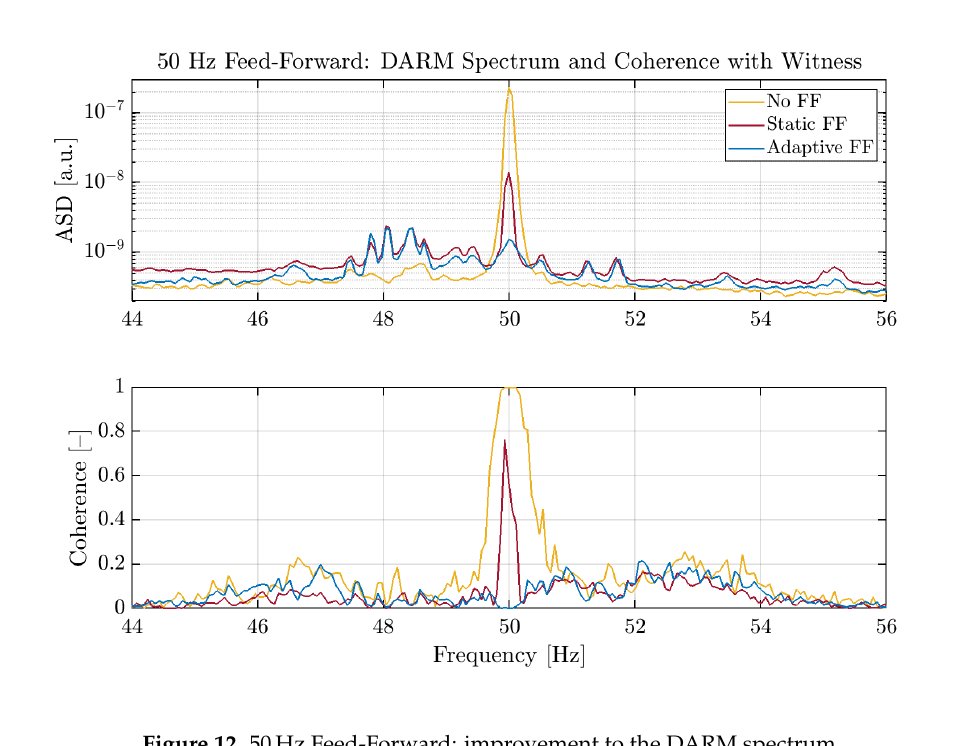
Figure 12. 50Hz Feed-Forward: improvement to the DARM spectrum.